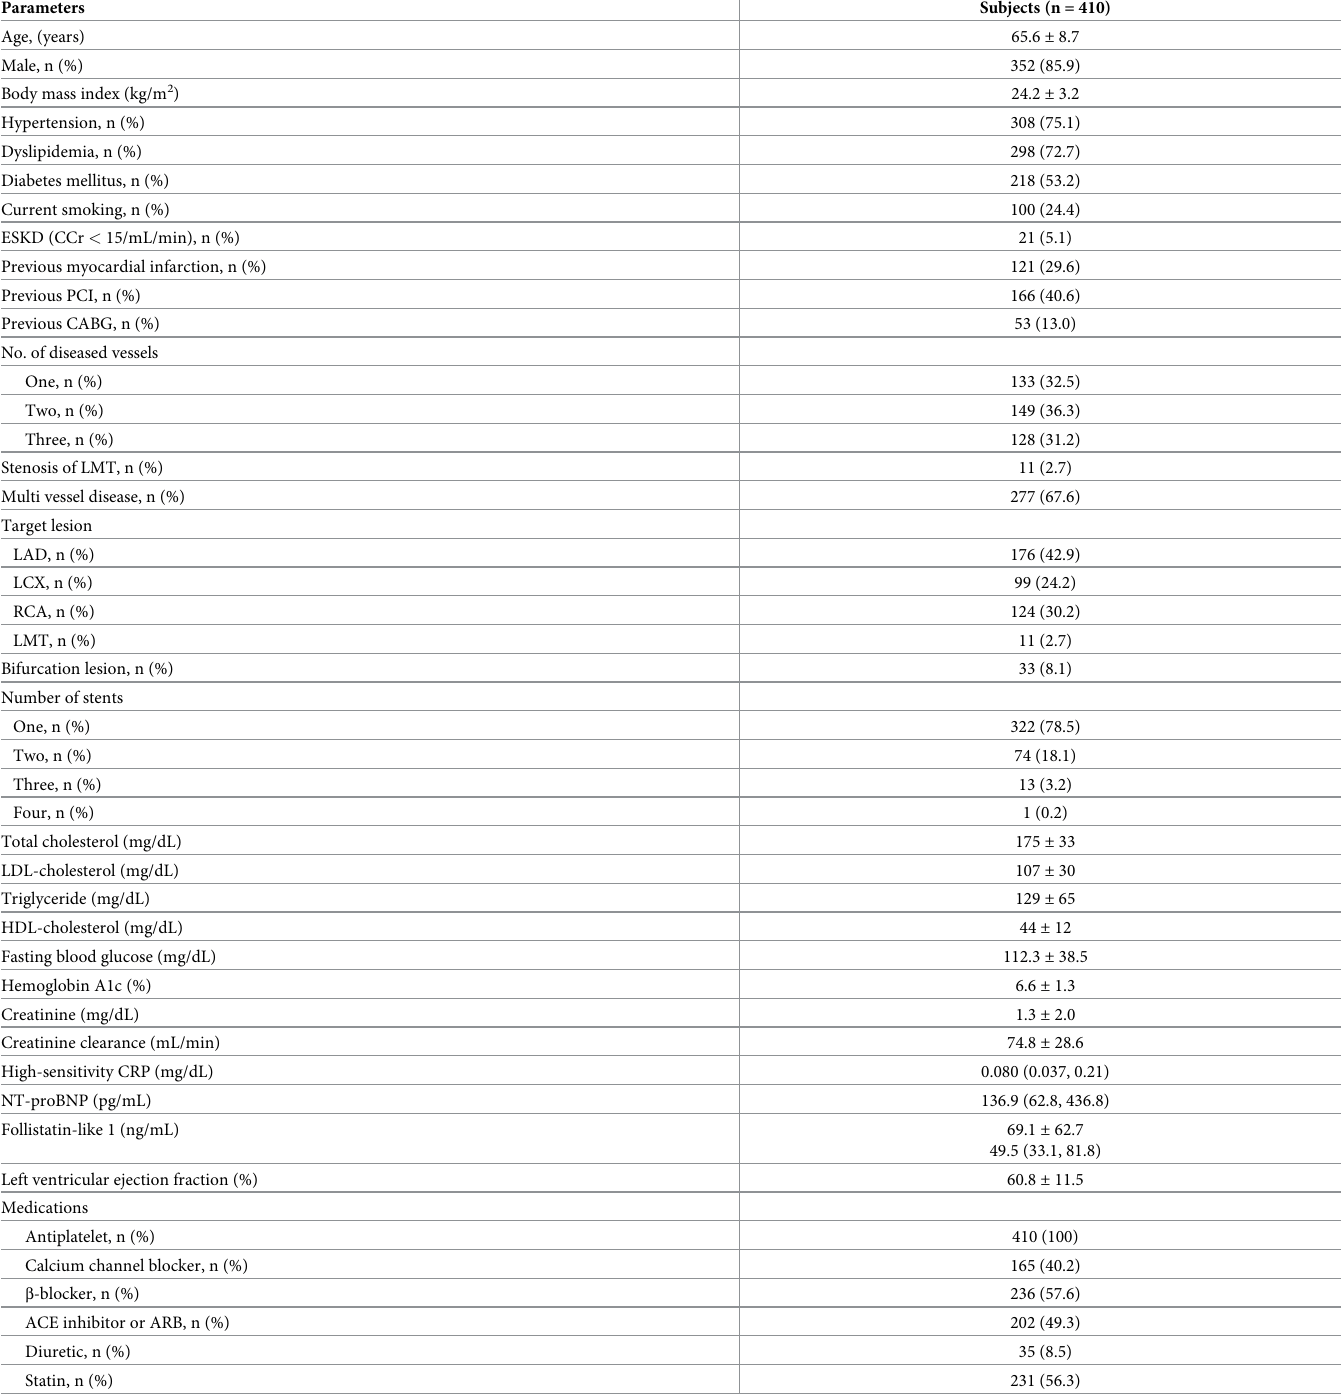
Table 1. Patient characteristics of the study